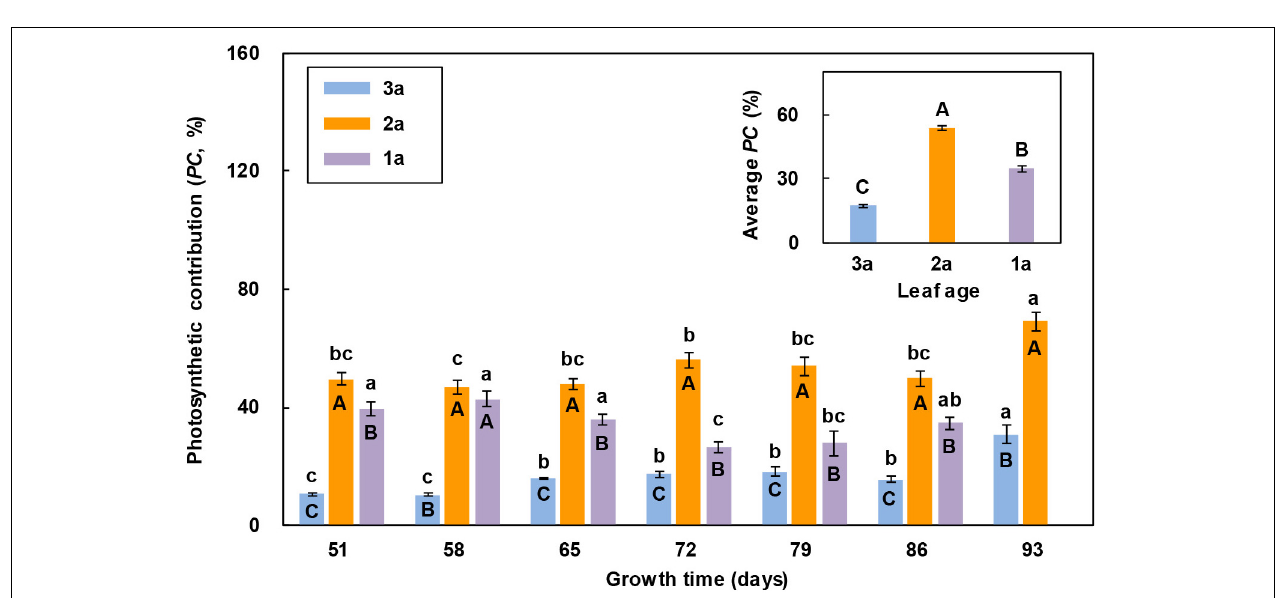
FIGURE 3 | Comparison of the photosynthetic contribution percentage ( PC ) of three leaves of reproductive ramets over time (means ± SE, n = 10) in Leymus chinensis . Different lowercase letters indicate significant differences ( P < 0.05) between the growth times for the same leaf age; different capital letters indicate significant differences ( P < 0.05) between the leaf ages for the same growth time. The average PC of seven growth times is presented as an inset figure. The dates corresponding to the seven growth times are May 26, June 2, June 9, June 16, June 23, June 30, and July 7 in